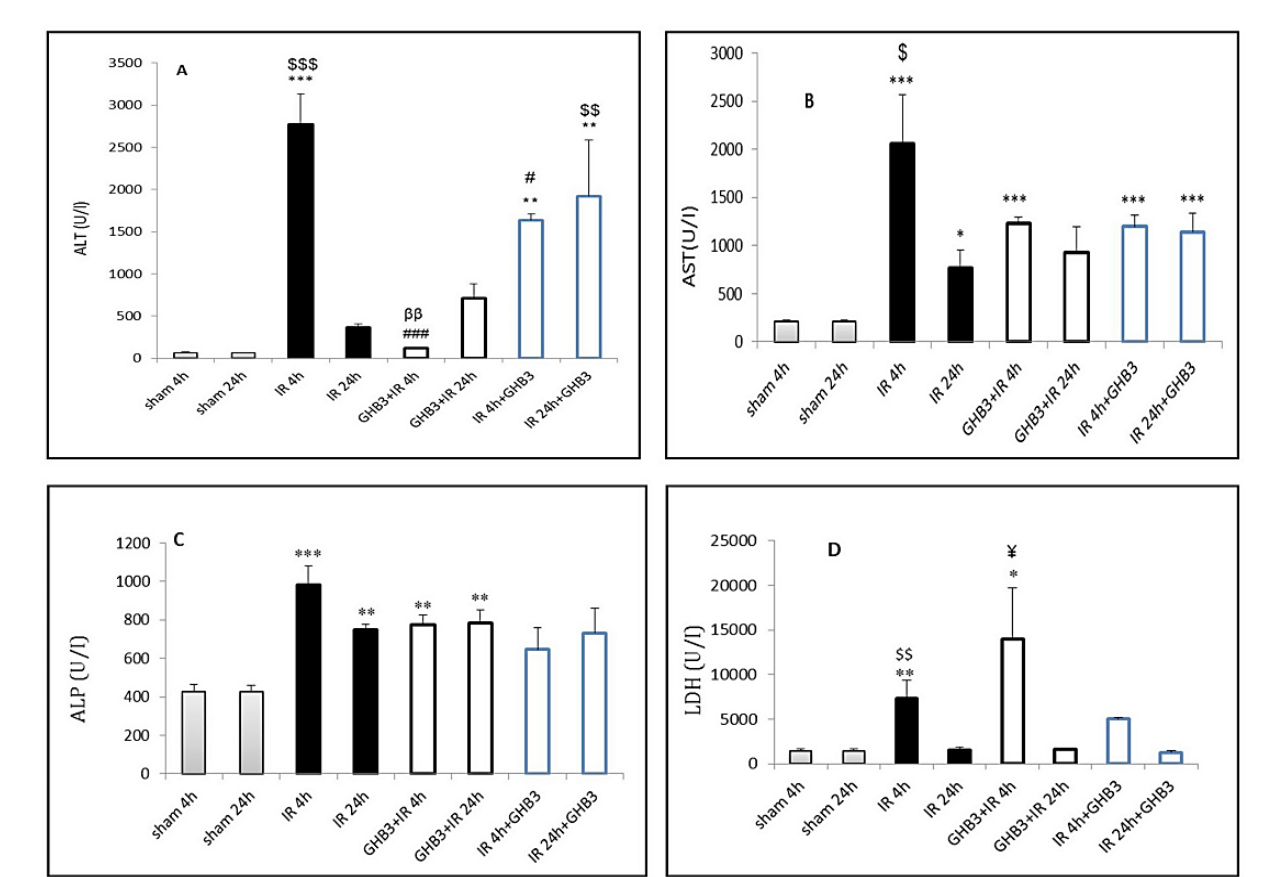
Figure 2. Changes in serum ALT ( A ), AST ( B ), ALP ( C ), and LDH ( D ) following 4 or 24 h of reperfusion in liver IR groups and effects of GHB on liver enzymes. Results are presented as the mean±S.E.M. Statistical analysis was performed by one-way ANOVA using post hoc Tukey test. P-value<0.05 was considered statistically significant. *: indicates significant differences vs the sham group (*:P-value <0.05, **: P-value <0.01, ***: P-value <0.001). #, ###: indicate significant difference vs IR4h group (#:P-value <0.05, ###: P-value <0.001). $: indi - cates significant differences vs IR24h group ($:P-value <0.05, $$: P-value <0.01, $$$: P-value <0.001). ¥: indicates significant differences vs. GHB3+IR24h group (¥:P-value <0.05). ββ: indicates significant differences vs. IR4h+ GHB3 group (ββ: P-value